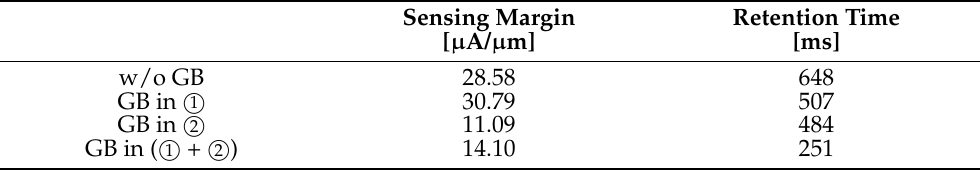
Figure 12. ( a ) Cross-section depending on the GB location of the proposed 1T-DRAM. ( b ) Variation of currents in read “1” and read “0” status depending on the GB position. Table 3. Memory performance depending on the GB location of the proposed